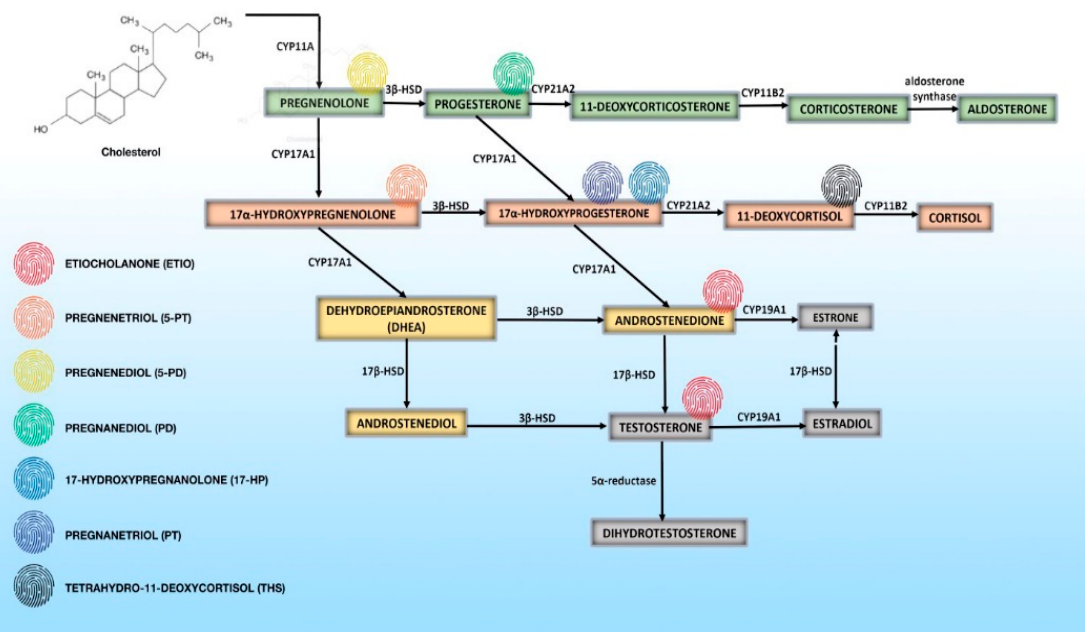
Figure 1. Overview of normal steroidogenesis and urinary steroid metabolites i.e., “malignant steroid fingerprint” indicative of adrenocortical carcinoma [56,68–70].